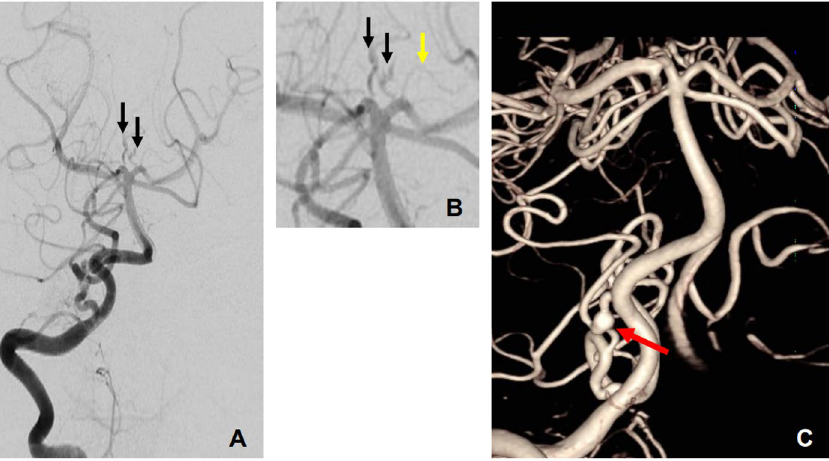
Figure 3. Right vertebral artery angiography of the patient. Anterior–posterior view of the right vertebral artery ( A , B ). Compared with the normal perforator (yellow arrow), the perforators of both posterior cerebral arteries (black arrows) were tortuous and dilated. Short segmental dilatation and aneurysm formation of the right anterior inferior cerebellar artery (red arrow) was